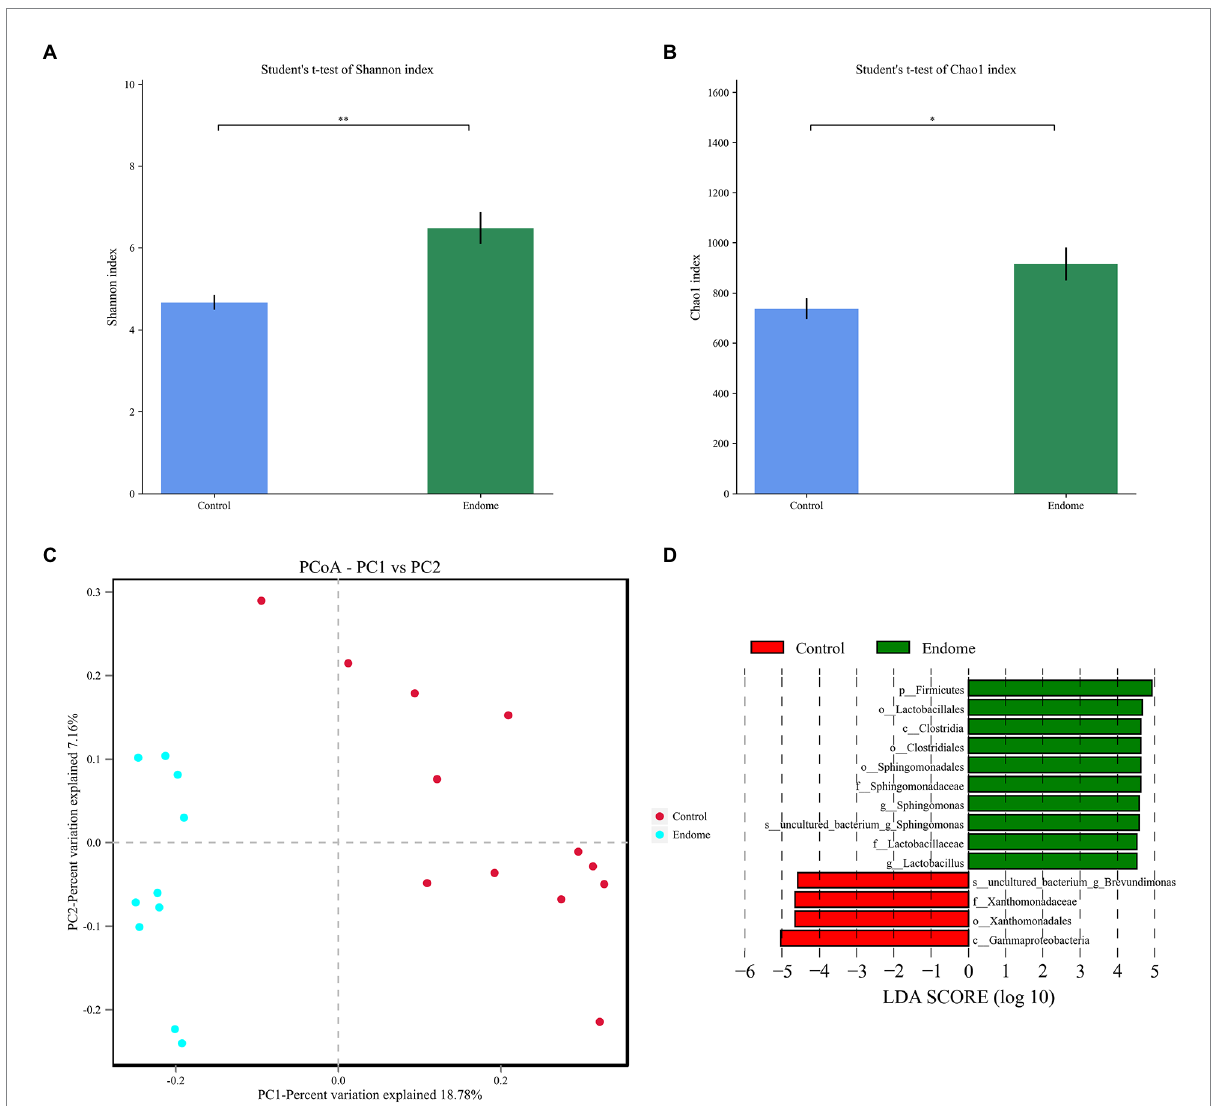
FIGURE 3 Bacterial diversity analysis of endometrial microbiota in donkey jennies of group C and group E. Shannon index (A) and Chao index (B) of the OTU level in endometrial microbiota of group C and group E. C: Healthy donkeys jennies. E: Donkey jennies with endometritis. *Significant difference ( P < 0.05, Student’s t -test). **Significant difference ( p < 0.01, Student’s t -test). (C) Principal coordinate analysis (PCoA) of the endometrial microbiota of healthy and endometritis donkeys based on Bray–Curtis distance. C: Healthy donkeys ( n = 12) in red; E: endometritis donkeys ( n = 10) in